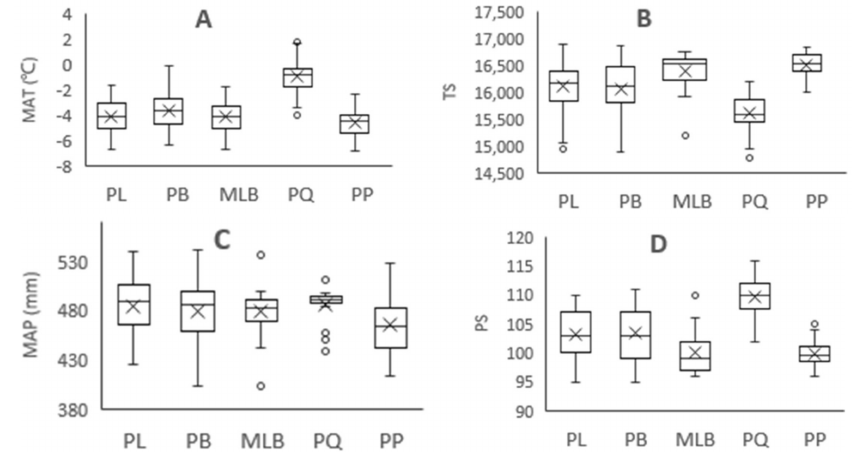
Figure 3. Variation of climatic factors in different forest types. MAT = mean annual temperature, TS = temperature seasonality, MAP = mean annual precipitation, and PS = precipitation seasonality. PL = pure Larix gmelinii (Rupr.) Kuzen forest, PB = pure Betula platyphylla Suk. Forest, MLB = Larix gmelinii (Rupr.) Kuzen and Betula platyphylla Suk. mixed forest, PQ = pure Quercus mongolica Fisch . ex Ledeb. forest, PP = pure Pinus sylvestris L. var. mongolica Litv. Forest. A : MAT of five forest types, B : TS of five forest types, C : MAP of five forest types, D : PS of five forest types. “ × ” = average value, “